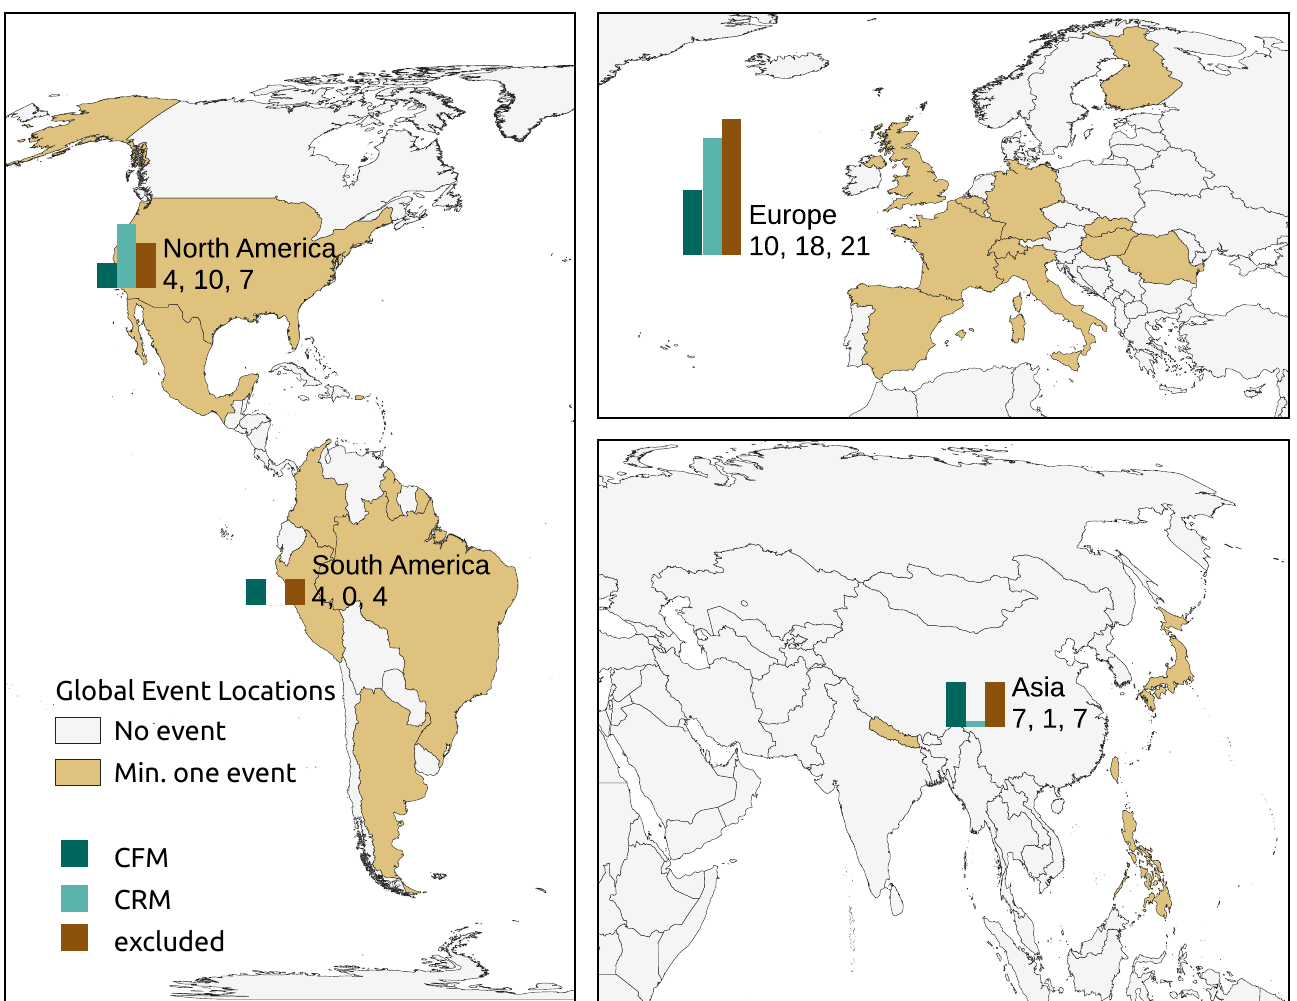
Figure 4. Distribution of event locations by type. While Community Field Mappings (CFMs) were globally distributed, Community Remote Mappings (CRMs) were organised nearly exclusively in North America and Europe. Source: Own work based on Natual Earth Contributors [43]. Projection: Eckert